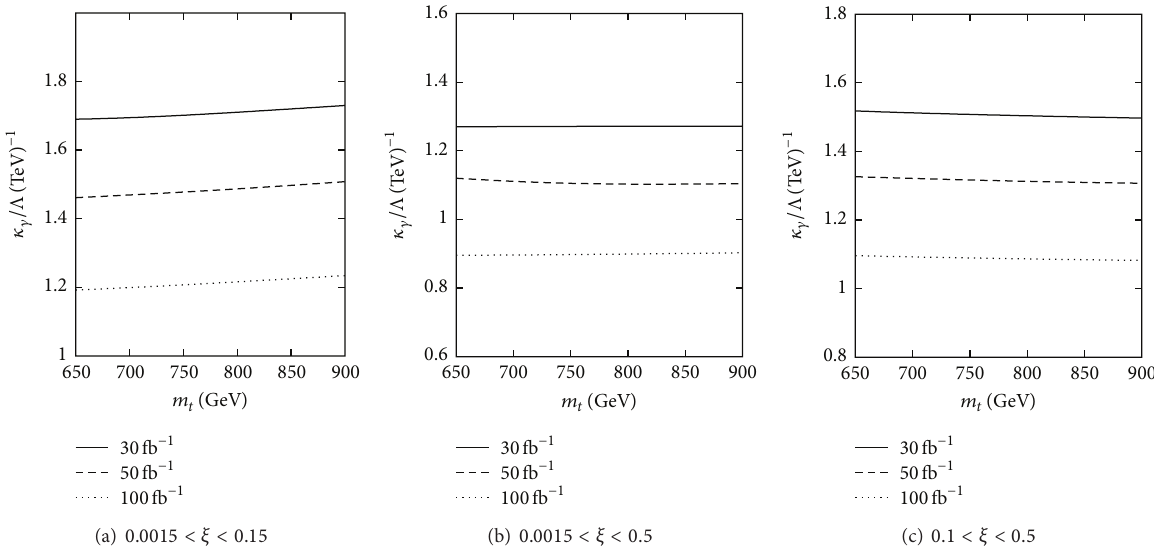
Figure 2: The parameter plane of 𝑚 𝑡 󸀠 and 𝜅 𝛾 /Λ at 95 % CL using Poisson analysis for three different luminosities: 30 , 50 , and 100 fb −1 . In (a) and (b), we use the different 𝑝 𝑡 values for every acceptance region to obtain less than 0.5 event number of SM: (a) 𝑝 𝑡 = 380 GeV for acceptance region 0.0015 < 𝜉 < 0.15 ; (b) 𝑝 𝑡 = 452 GeV for acceptance region 0.0015 < 𝜉 < 0.5 . In (c), we applied a 𝑝 𝑡 cut of 𝑝 𝑡 = 50 GeV for acceptance region 0.1 < 𝜉 < 0.5